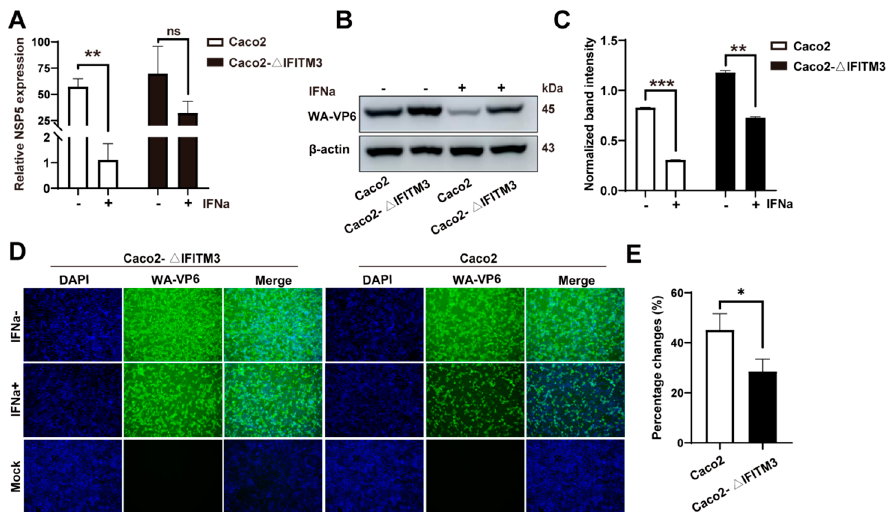
Figure 5. Knockout of IFITM3 attenuates the IFN–induced anti–RV activity. ( A ) RT–qPCR analysis of Wa–NSP5 in Caco2 and Caco2– Δ IFITM3 cells that were, respectively, infected with the Wa strain at 0.2 MOI for 24 h after IFNa2b treatment for 12 h. ( B ) Western blot analysis of Wa–VP6 in Caco2 and Caco2– Δ IFITM3 cells infected with the Wa strain, respectively, at 0.2 MOI for 24 h after IFNa2b treatment for 12 h. ( C ) Bands analysis from panel B were quantified using ImageJ software and normalized to the reference genes β –actin. ( D ) Immunofluorescence analysis (40×) of Wa strain infection for 24 h in Caco2 and Caco2– Δ IFITM3 cells after IFNa2b treatment for 12 h. ( E ) Declined percentages of infected cells in Caco2 and Caco2– Δ IFITM3 cells after IFNa2b treatment. ( A , C , E ) Results represented the mean ± SD and were measured in technical duplicates, n = 3. ns, p > 0.05; *, p < 0.05; **, p < 0.01; ***, p <0.001 (Student’s t test).